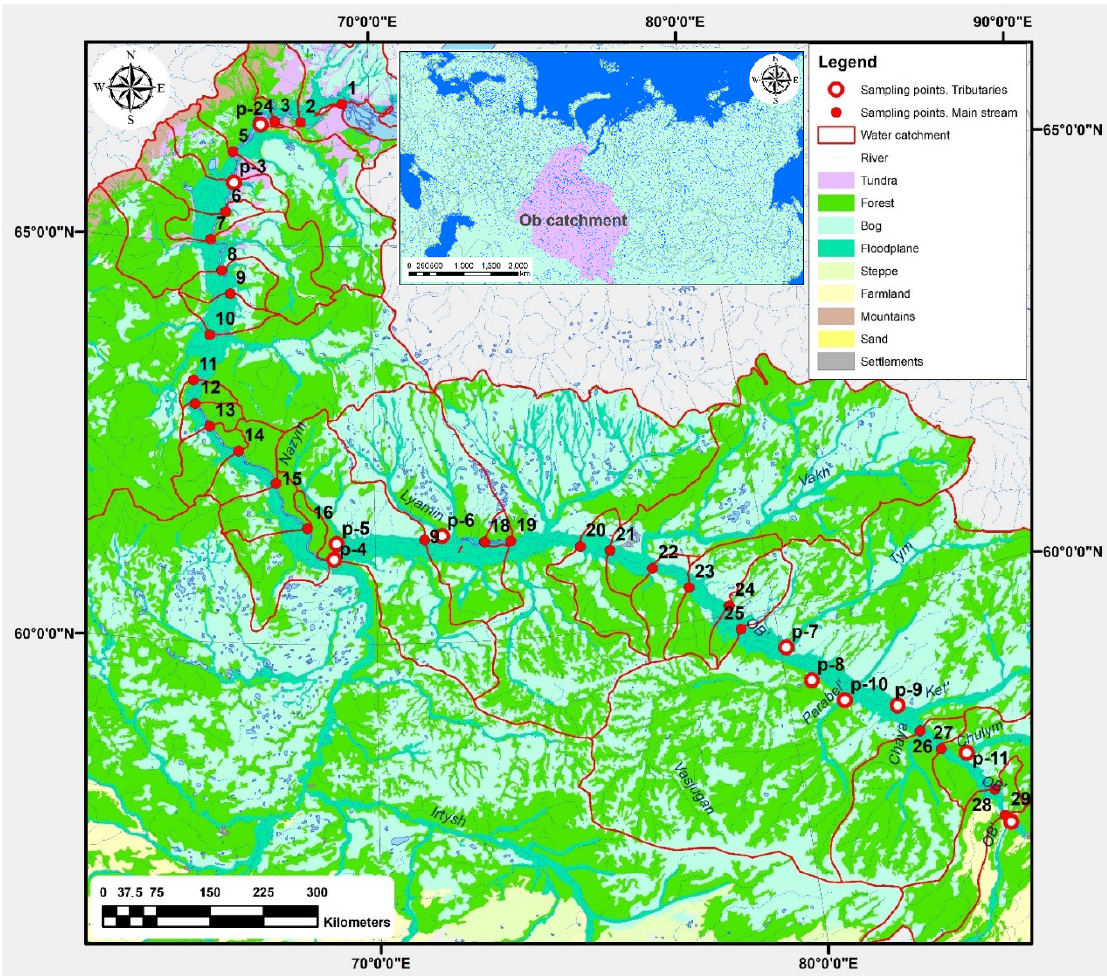
Figure 1. The Ob River and tributaries sampling points (solid and open circles, respectively) showing the dominant landscapes of the Ob River basin.